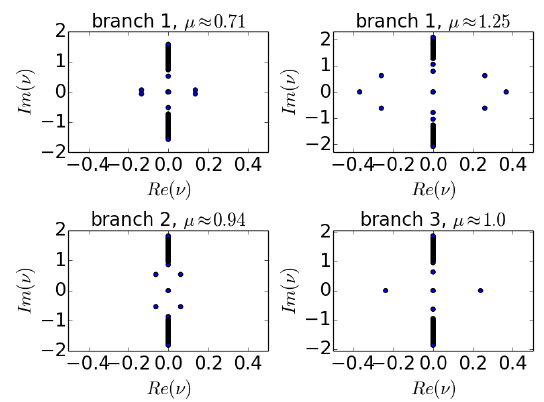
Figure 4. Eigenvalues are plotted in the complex plane ( Re ( ν ) , Im ( ν )) for a few representative solutions. One can compare the maximal real part with Figure 3. For example, the top left complex plane plot here shows that for branch 1 at µ ≈ 0.71, the eigenvalues with the maximum real part are complex; this agrees with the top left plot of Figure 3 where at µ ≈ 0.71, the blue dotted curve representing complex eigenvalues is bigger. Similarly, one can check whether the other three eigenvalue plots here also agree with what is shown in Figure 3, the top right for branch 1, the bottom left for branch 2 and the bottom right for branch